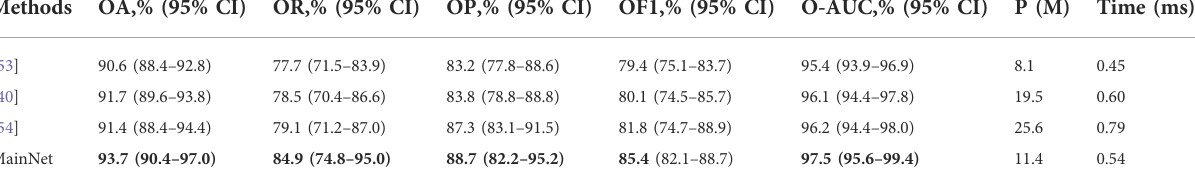
TABLE 4 Statistical comparison with other related advanced methods.